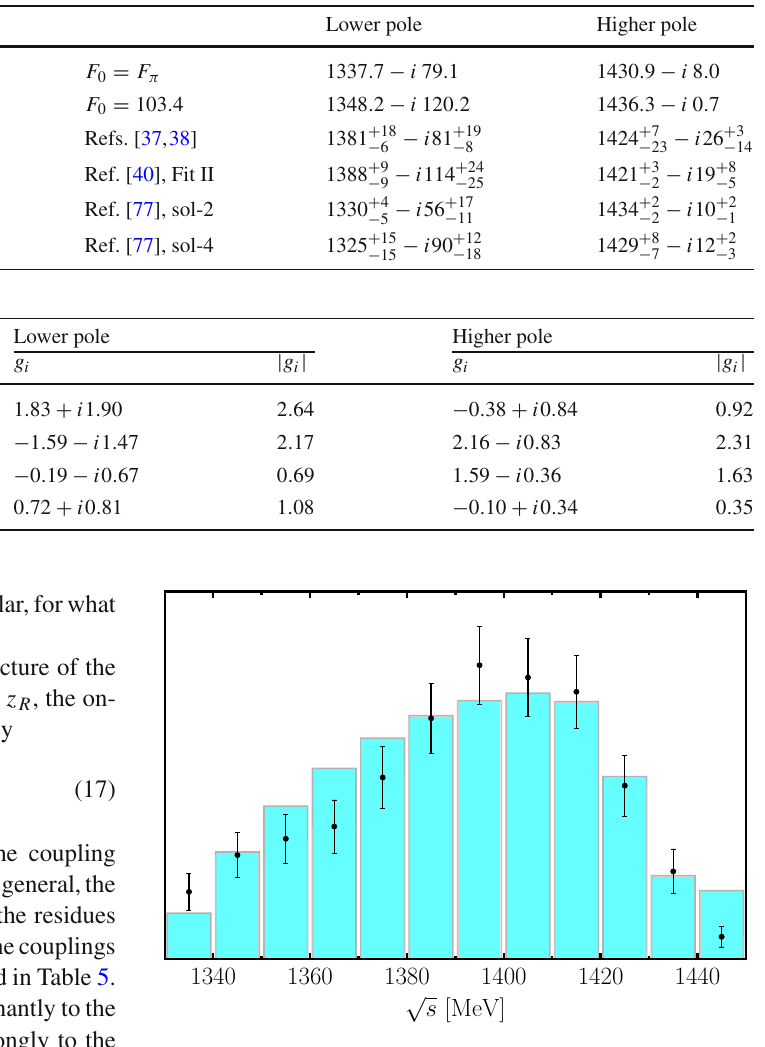
Fig. 3 π(cid:4) invariant mass spectrum with I = 0 in arbitrary units. The histogram represents the result of our calculations as explained in the text. Experimental data for the π − (cid:4) + event distribution are taken from Ref.